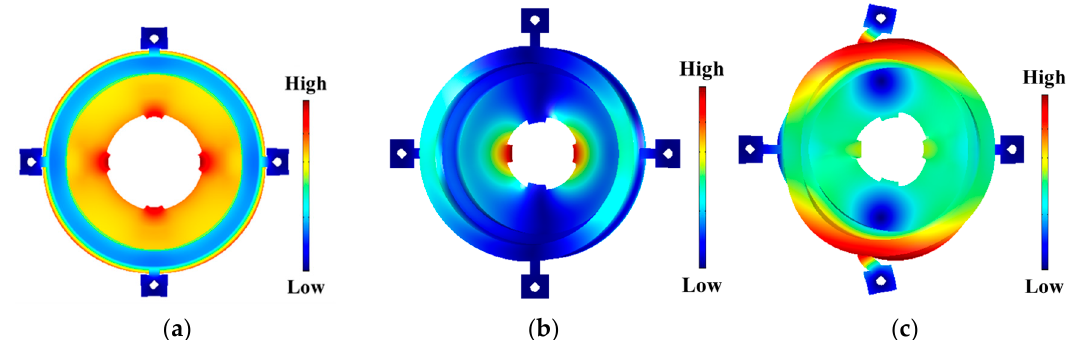
Figure 4. Strain distribution in the stator during each vibration mode. ( a ) R 1 -mode, ( b ) B 21 -mode, and ( c ) ((1,1))-mode. Animations of simulated vibration modes and an elliptical displacement motion are available as Supplement Materials.